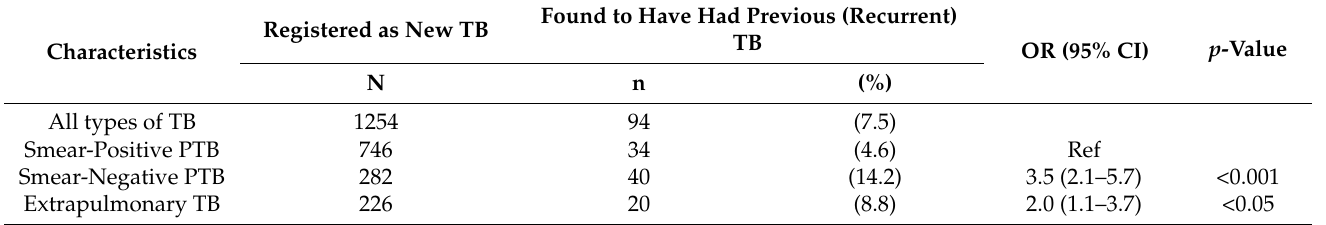
Table 1. Recurrent tuberculosis in patients registered in Malawi as having “new”